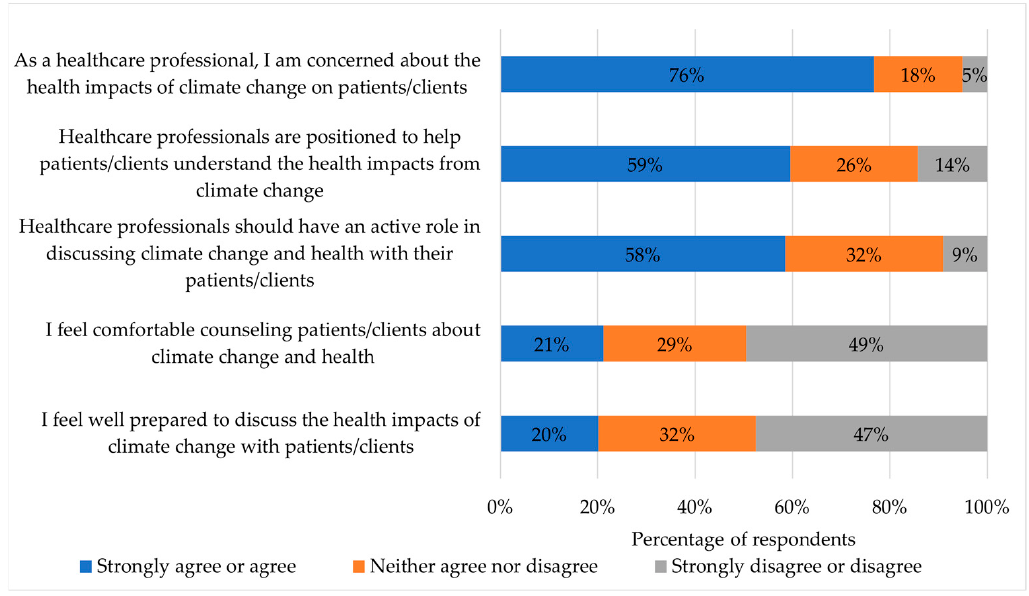
Figure 2. Respondent self-reported level of concern, preparation, comfort, role in addressing climate change, and whether they feel positioned to help patients or clients (n = 3448).